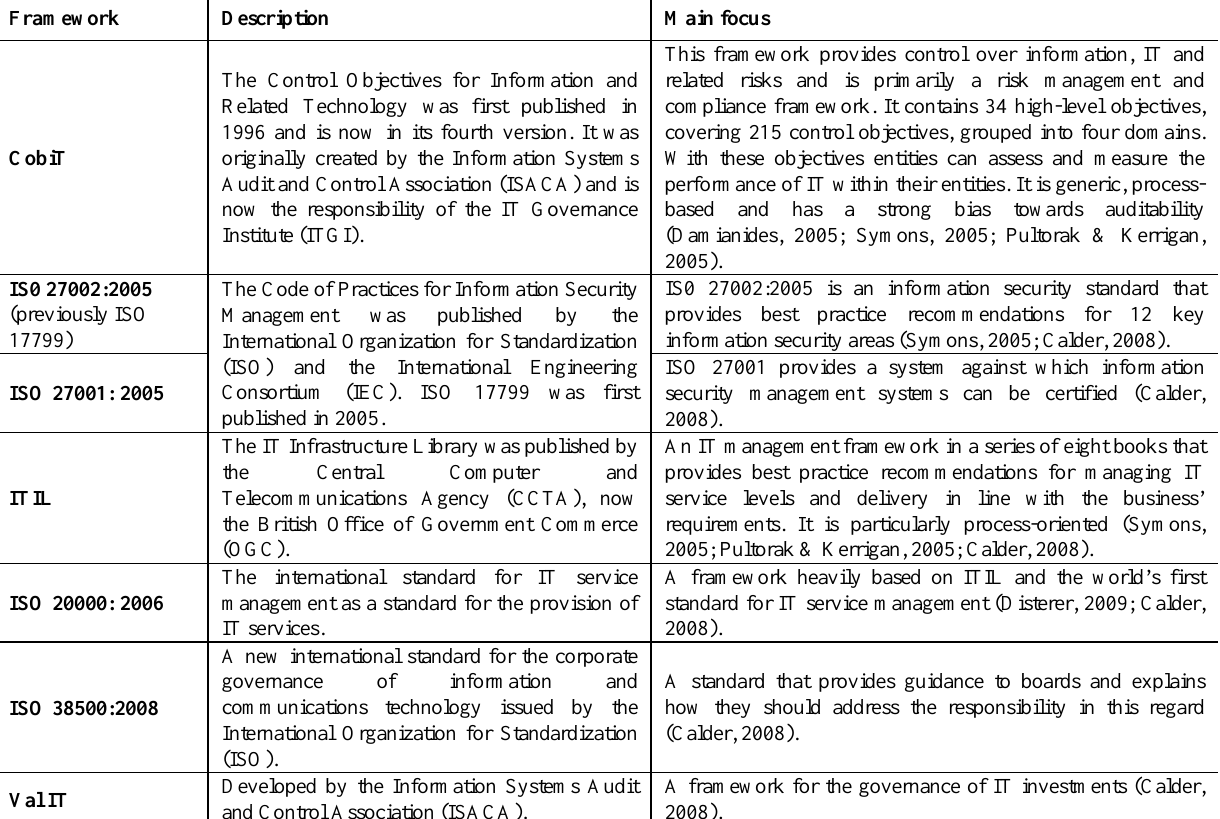
Table 2: Most popular IT governance frameworks